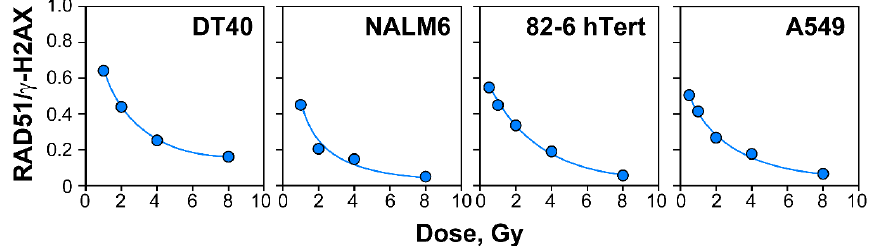
Figure 4. The contribution of HR to the repair of DSBs decreased with an increasing radiation dose in both lymphoblastic and other somatic cell lines. Plots illustrating the ratio between RAD51 foci, marking the number of DSBs repaired by HR and γ -H2AX foci, as an indicator of the overall DSB load. The numbers of γ -H2AX foci at radiation doses above 1 Gy were extrapolated from the fitted curves shown in Figure 2B,D, while the number of RAD51 foci at (t max ) was determined from the experiments shown in Figures 3 and S5.